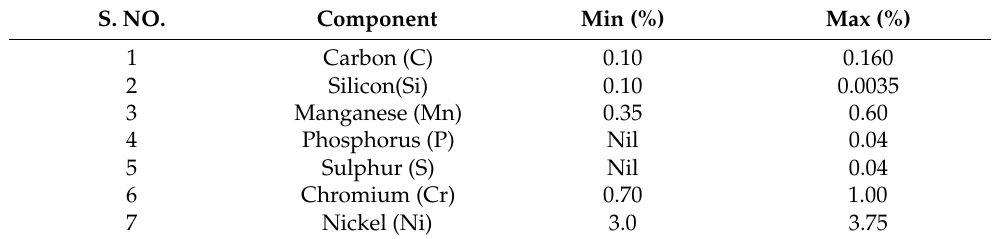
Table 2. Chemical composition of EN36B.